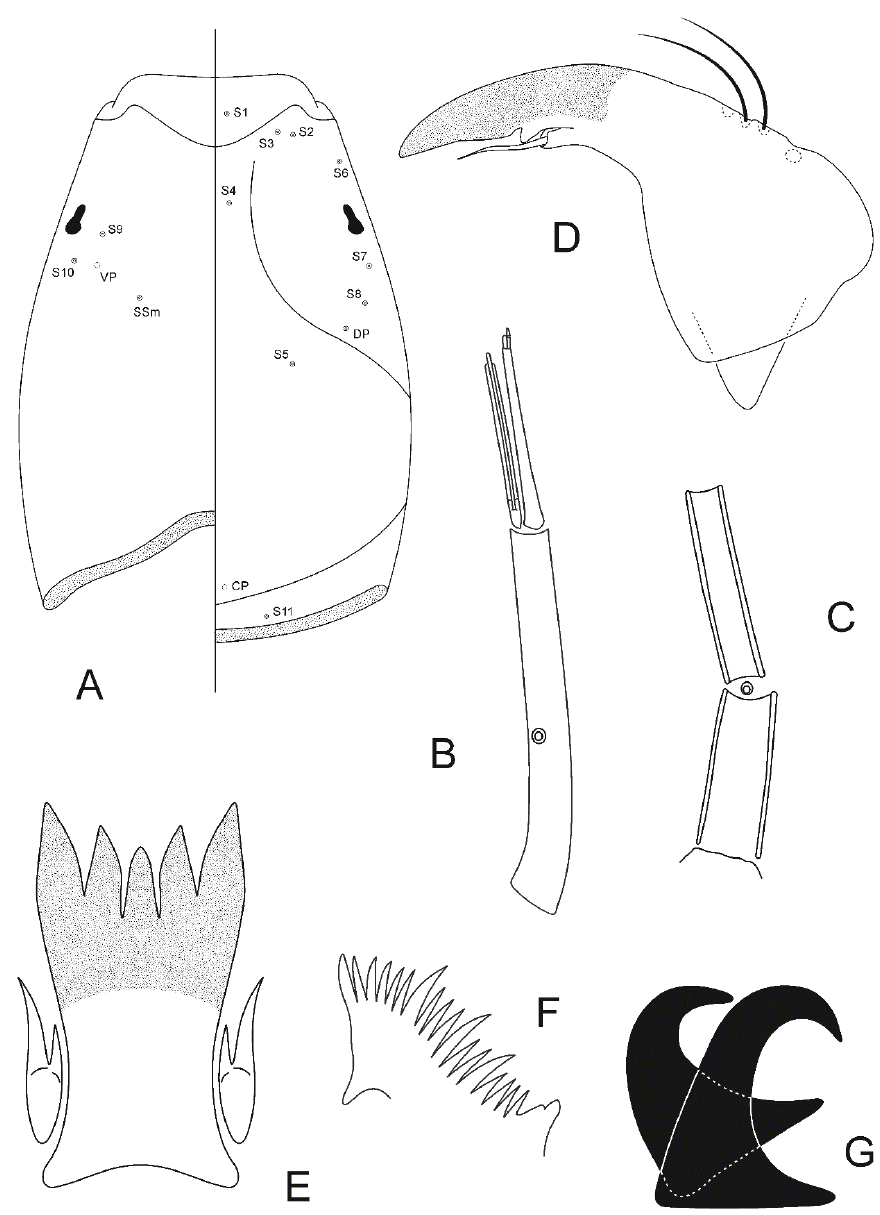
Figure 4. Ablabesmyia americana Fittkau. Larva: ( A ) Head with chaetotaxy. Left: Ventral view, right: Dorsal view. ( B ) Antenna. ( C ) Maxillary palp. ( D ) Mandible. ( E ) Ligula and paraligula. ( F ) Pecten hypopharyngis. ( G ) Dark claws of posterior parapod.